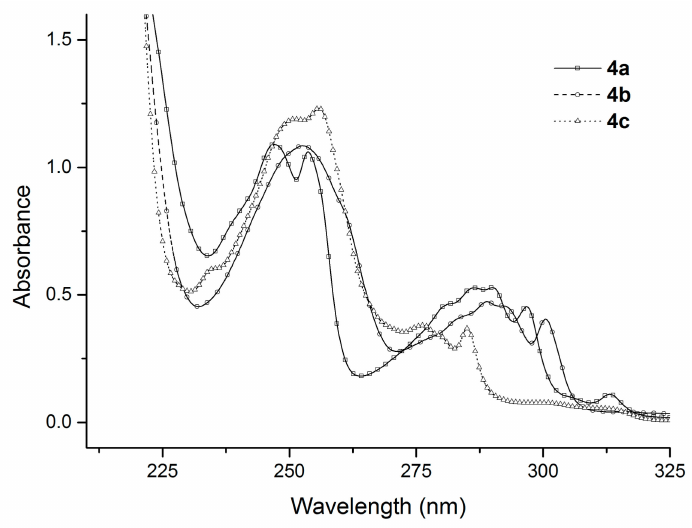
Figure 2. The absorption spectra of the benzofuran derivatives 4a – c recorded in 10 − 4 M cyclohexane